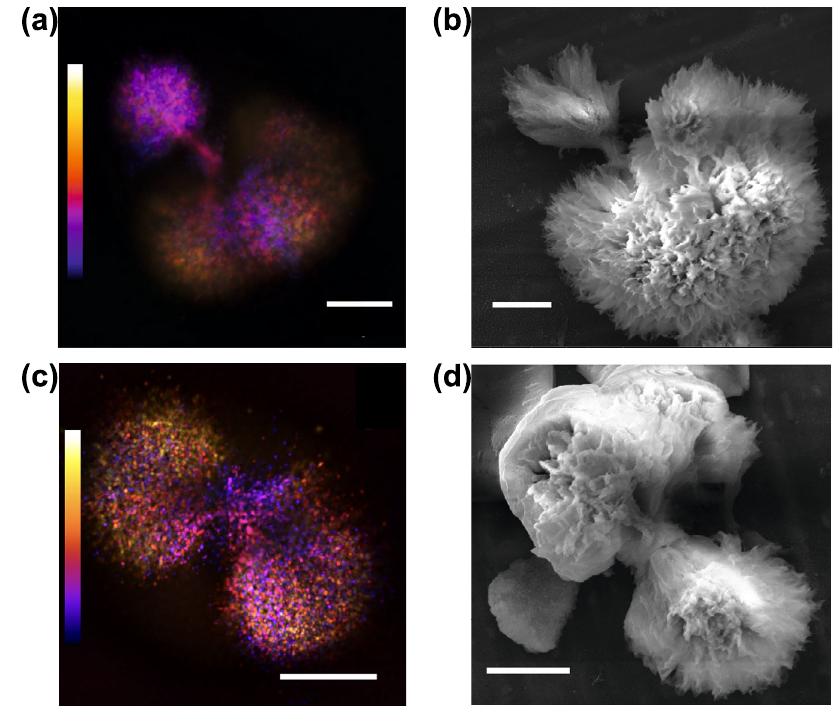
Fig. 2 Structure of anisotropically grown human insulin spherulites of two distinct growth-morphologies. a , b Spherulites with two asymmetric sides captured by spinning disk confocal microscopy and SEM, respectively. c , d Spherulites with symmetric two side structures captured by spinning disk confocal microscopy and SEM, respectively. Data in a , c were acquired for a sample from incubation time of 16 h at 60 °C. Data in ( b , d ) are for a sample from an incubation time of 4 h at 60 °C. Color scales are from − 14.04 to 14.04 μ m in a and − 8.46 to 8.46 μ m in c . Scale bars are 10 μ m. All samples were covalently labeled with Alexa Fluor